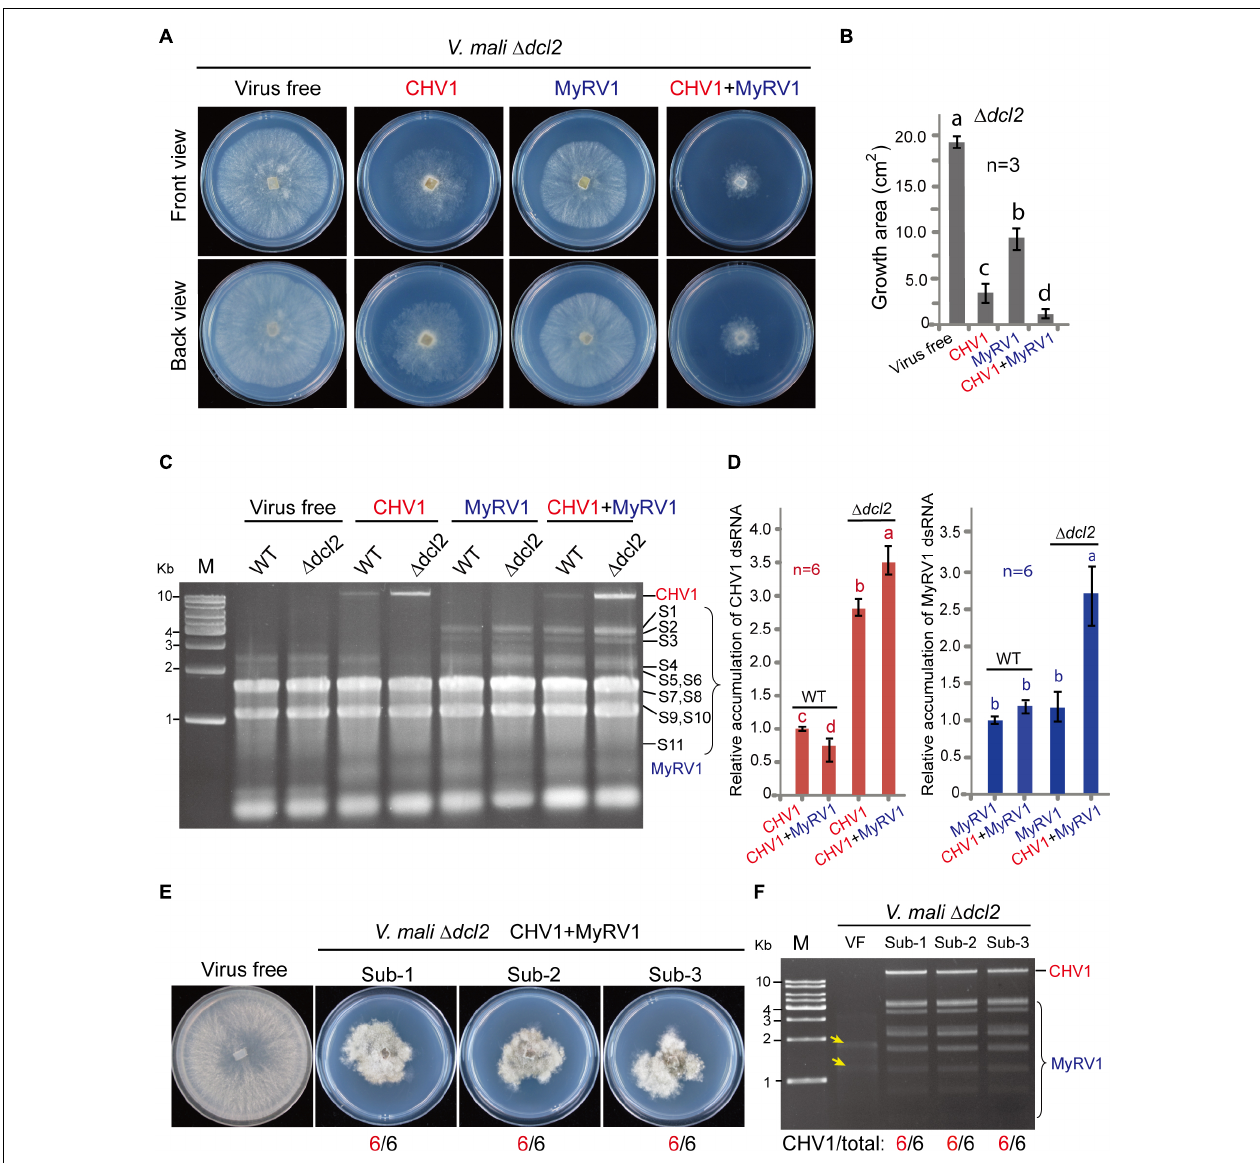
FIGURE 6 | The accumulation of CHV1 and MyRV1 in the dcl2 knockout mutant of V. mali . (A) The phenotypic growth on PDA medium of the representative V. mali mutant strains singly or doubly infected with CHV1 and MyRV1. The colonies were grown on PDA for 4 days and then photographed. (B) The growth areas of the fungal strains described in (A) . The data are the means ± SD ( n = 3). The different letters indicate a significant difference at p < 0.01 (one-way ANOVA). (C) Agarose gel electrophoresis of the total RNA samples extracted from the wild-type and dcl2 knockout mutant of V. mali strains singly or doubly infected with CHV1 and MyRV1. The total RNA samples were analyzed via electrophoresis in agarose gel stained with ethidium bromide. (D) The relative dsRNA accumulation levels of CHV1 and MyRV1 in the wild-type and (cid:49) dcl2 knockout mutant. The dsRNA bands detected in the experiment described in (C) were quantified and analyzed using Image J Macro software. The data are the means ± SD ( n = 6). The different letters indicate a significant difference at p < 0.01 (one-way ANOVA). (E) The phenotypic growth on PDA medium of the representative V. mali mutant strains co-infected with CHV1 and MyRV1 in the first to third fungal subcultures (Sub-1 to Sub-3). The colonies were grown on PDA for 6 days and then photographed. The numbers below the images indicate the number of fungal colonies showing a similar phenotype as that presented in the photo per total number of colonies. (F) Viral dsRNA analysis of the doubly infected V. mali mutant strains described in (E) . The numbers below the lanes indicate the number of samples in which CHV1 dsRNAs were detected per total number of samples. Yellow-colored arrows mark the traces of ribosomal RNAs in virus-free (VF) sample incorporated during dsRNA